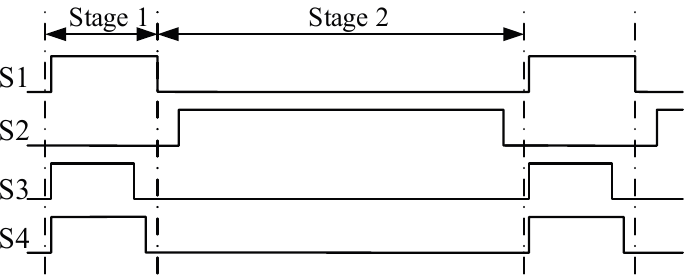
Figure 17. Timing diagram of the proposed comparator.